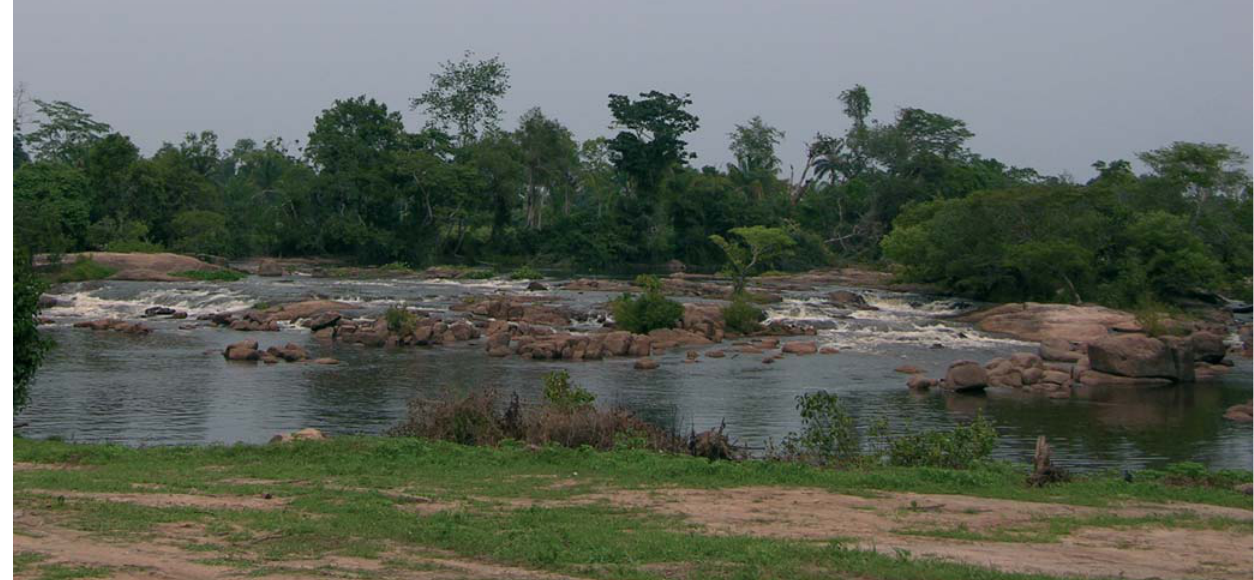
Fig. 6. Type locality of Bryconadenos weitzmani , at the rapids in the rio Curuá, near the village of Castelo dos Sonhos, Altamira, Pará, Brazil. Photo by Mark S.